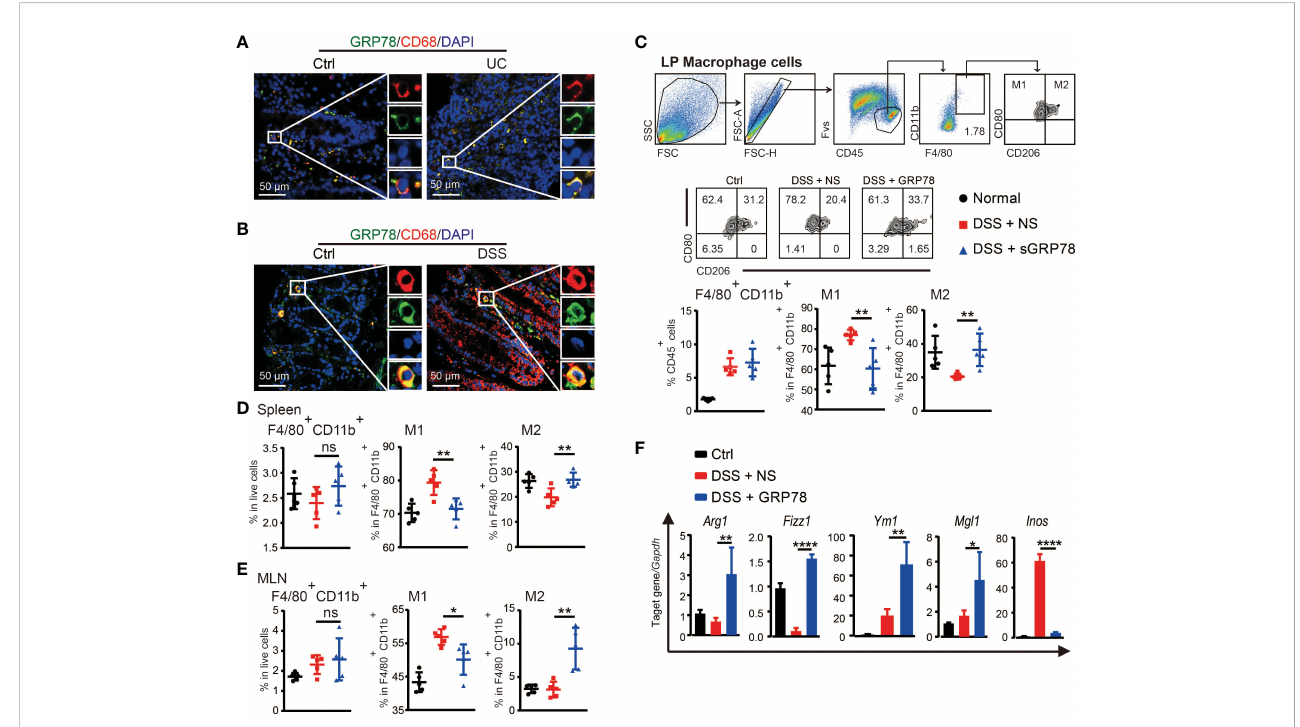
FIGURE 4 sGRP78 induced macrophage M2 polarization in colitis. Representative immuno fl uorescent images of GRP78 (green) and CD68 (red) stained human (A) and mouse (B) colonic mucosa. Scale bar: 50 m m. (C) Frequencies of F4/80 + cells in lamina propria (LP) and their CD80 + or CD206 + expressions. Upper: gating strategy followed to distinguish the LP macrophages. Middle: representative FCM dot plots. Lower: FCM plots based quantitative analysis for F4/80 + CD11b + macrophages. (D) Frequencies of indicated cell populations in spleen. (E) Frequencies of indicated cell populations in MLN. (F) mRNA expression of Arg1 , Fizz1 , Ym1 , Mgl1 , and Inos in mice colonic tissues (Ctrl group: black circle; DSS+NS group: red square; DSS+GRP78 group: blue regular triangle). Data represent mean ± SEM (n=5). ns, not signi fi cant. * p < 0.05, ** p < 0.01, **** p <